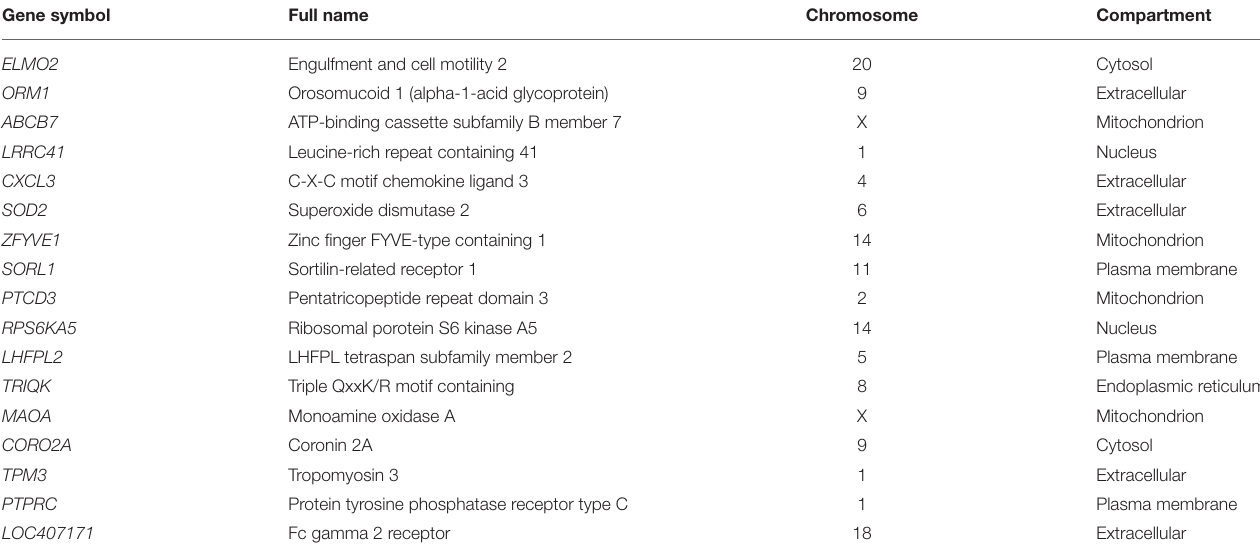
TABLE 2 | Significant common meta-genes in mastitis